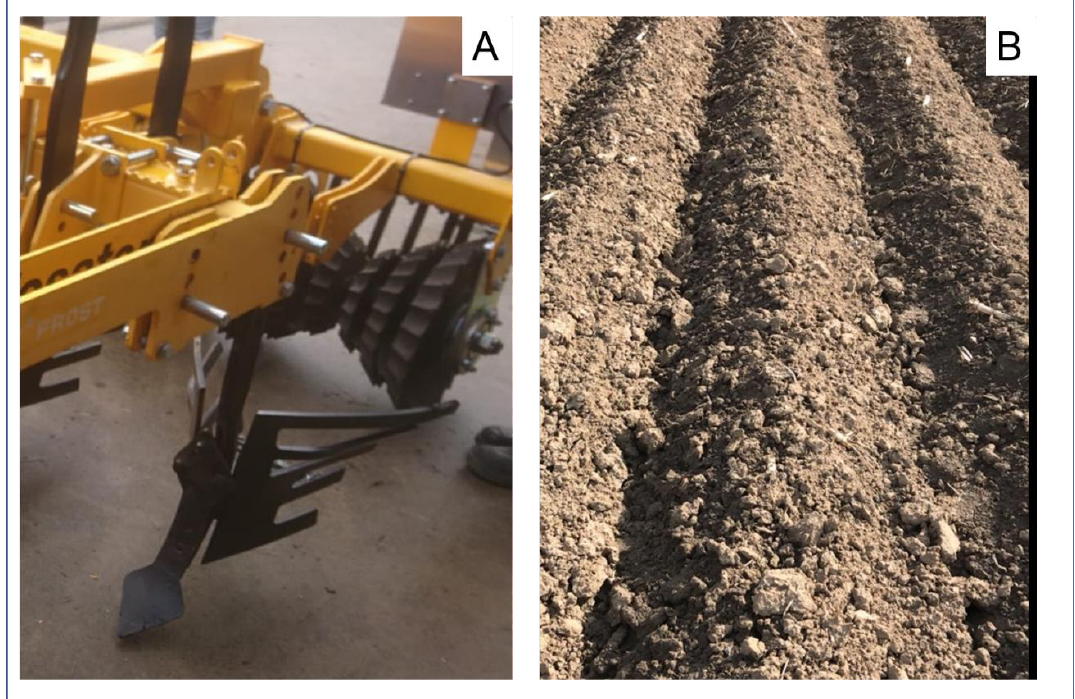
Figure 1. ( A ) Ridger and re-compacting discs. ( B ) Soil structure after ridging and re-compacting. Photo: R. Gerhards.